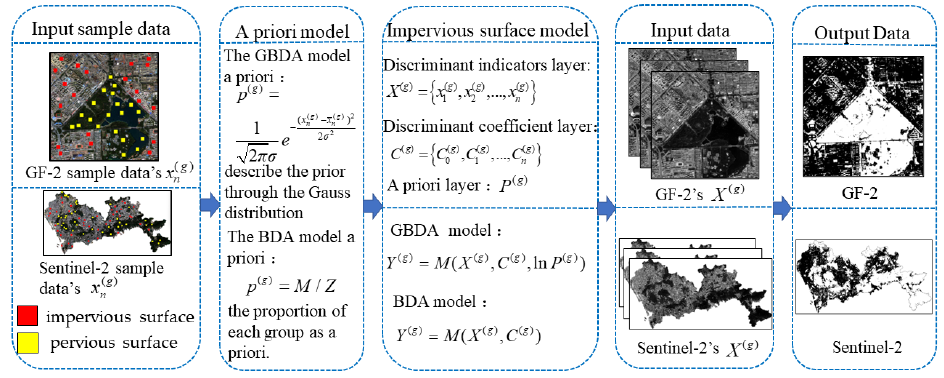
Figure 1. Overview of the GBDA and BDA.